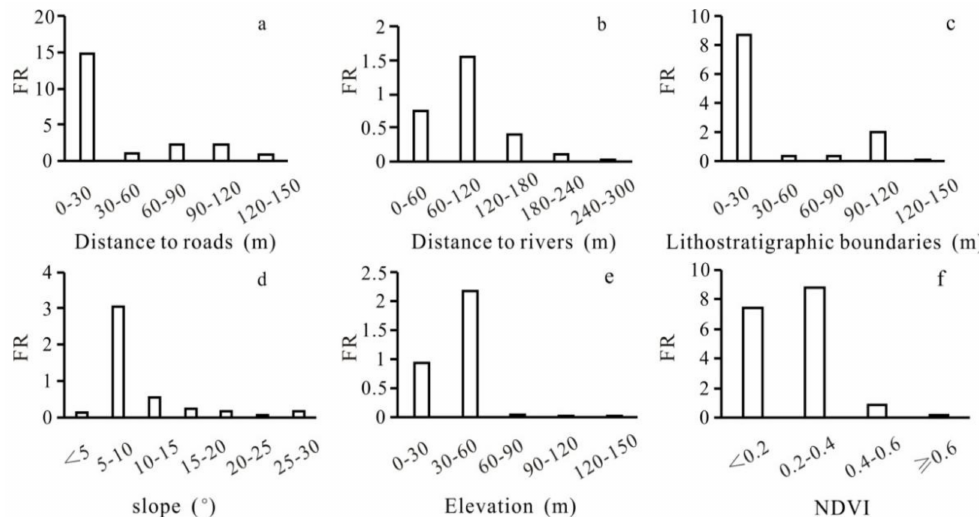
Figure 10. Frequency ratio (FR) of each geo-environmental factor: ( a ) distance to roads; ( b ) distance to rivers; ( c ) distance to lithostratigraphic boundaries; ( d ) slope; ( e ) elevation; and ( f )